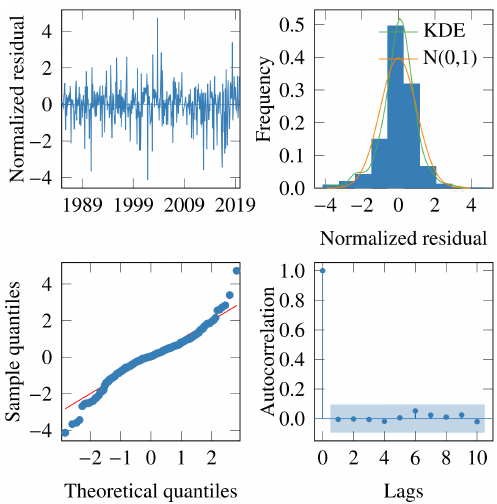
Figure 15. The residual diagnosis of the proposed ARIMA